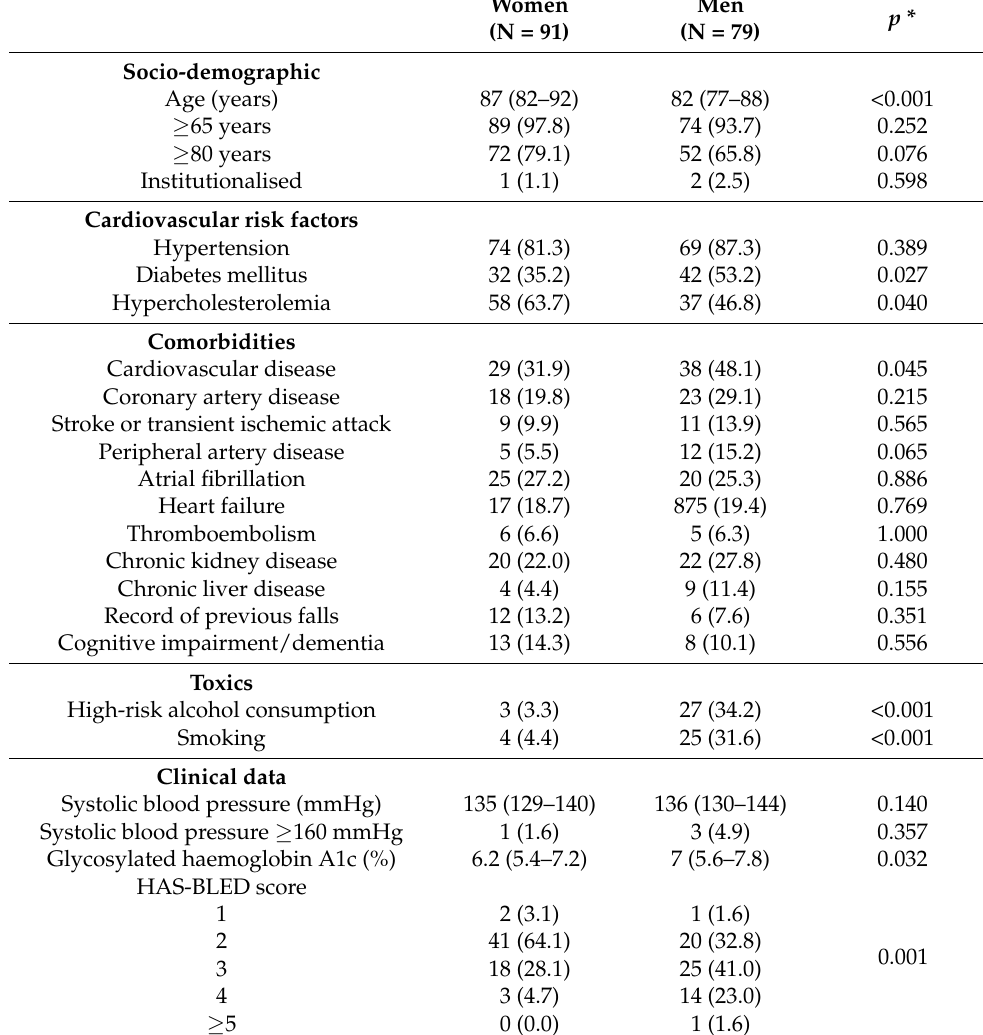
Table 2. Sex differences in GMA-4 population who suffered an ICH during